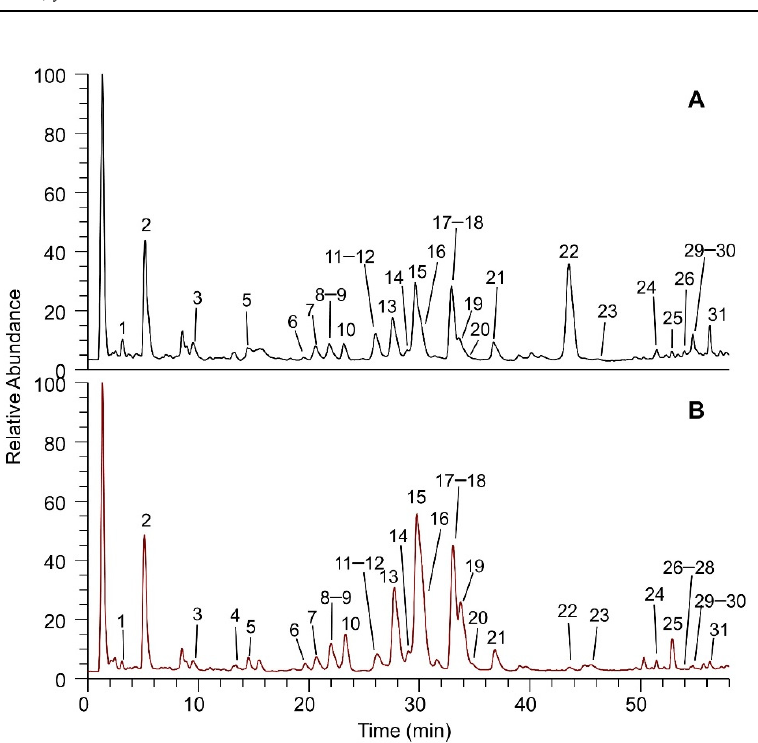
Figure 2. TICs of ( A ) aqueous extract and ( B ) methanolic extract of Achillea moschata. The peaks are numbered in progressive order based on the Retention Times (RT) and their assignment is reported in Table 1.